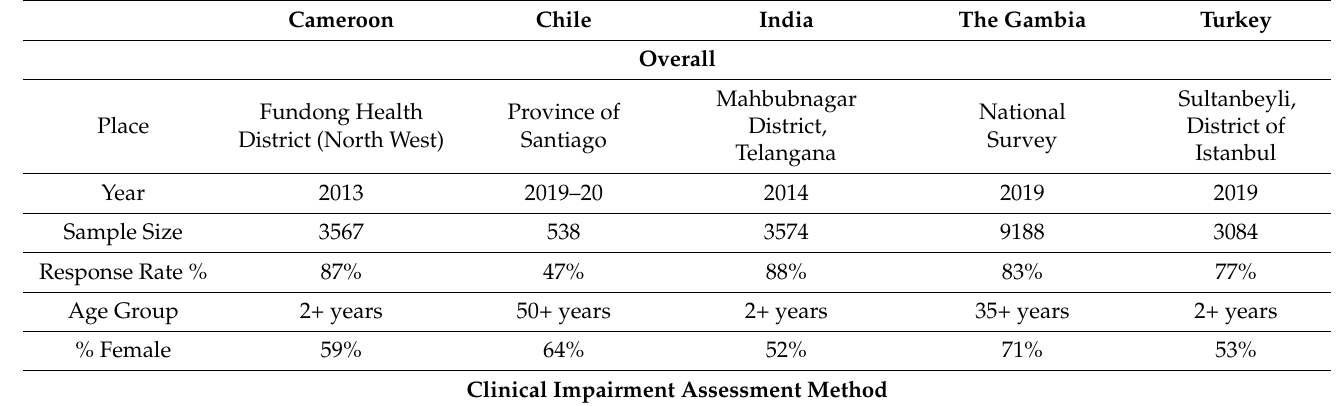
Table 1. Survey participants and clinical impairment assessments in Cameroon, Chile, India, The Gambia and